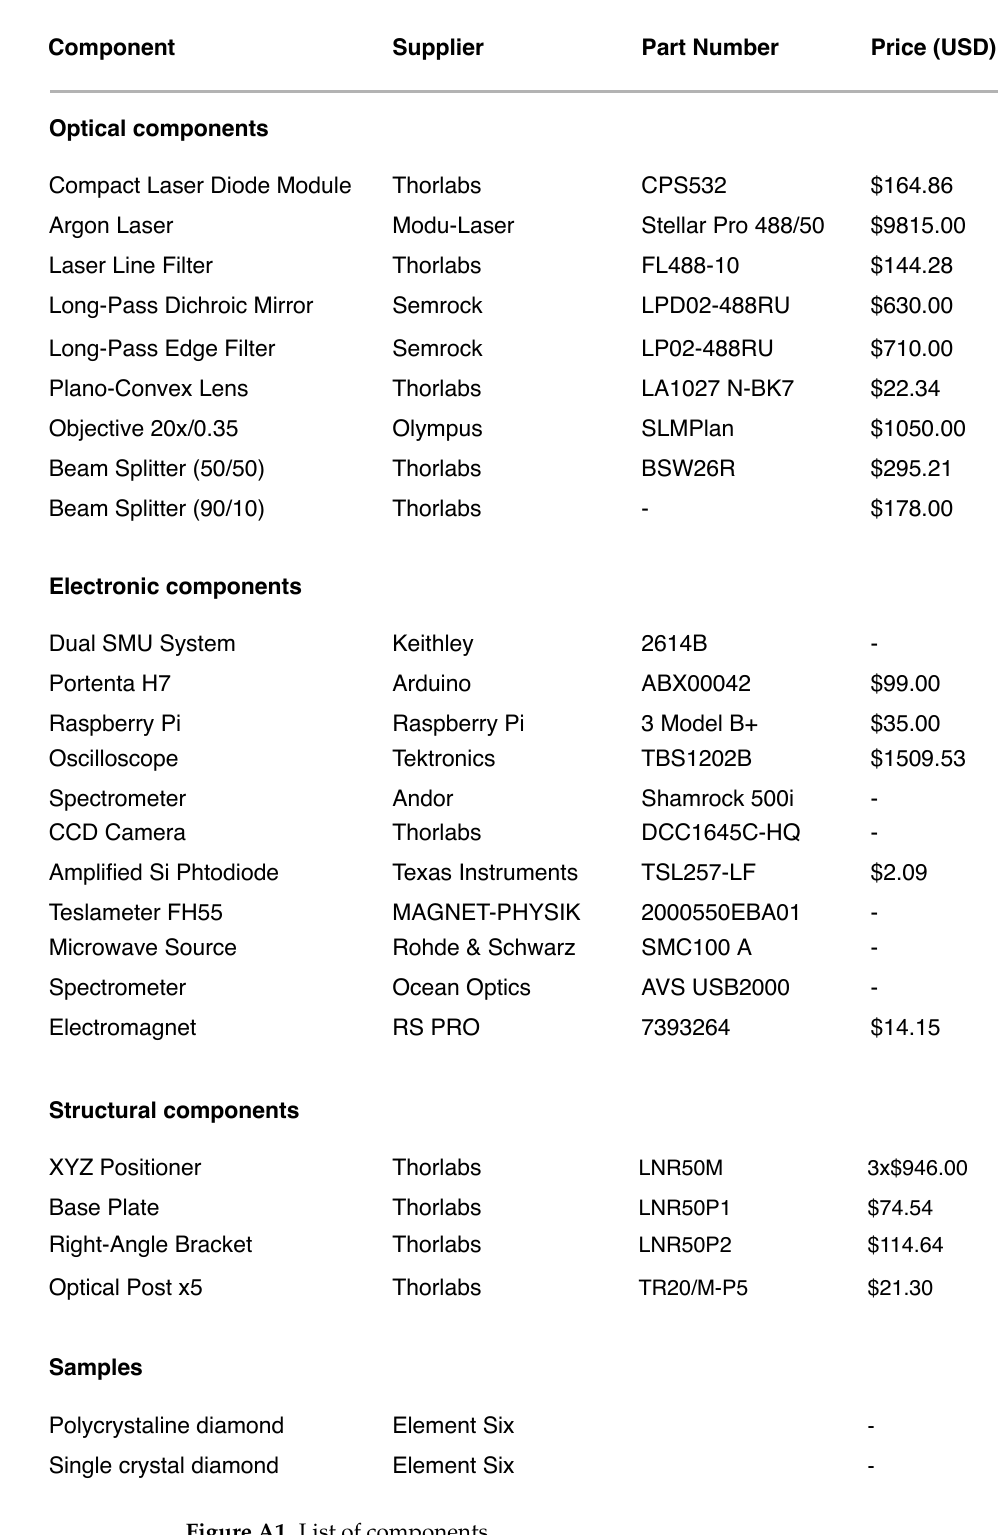
Figure A1. List of